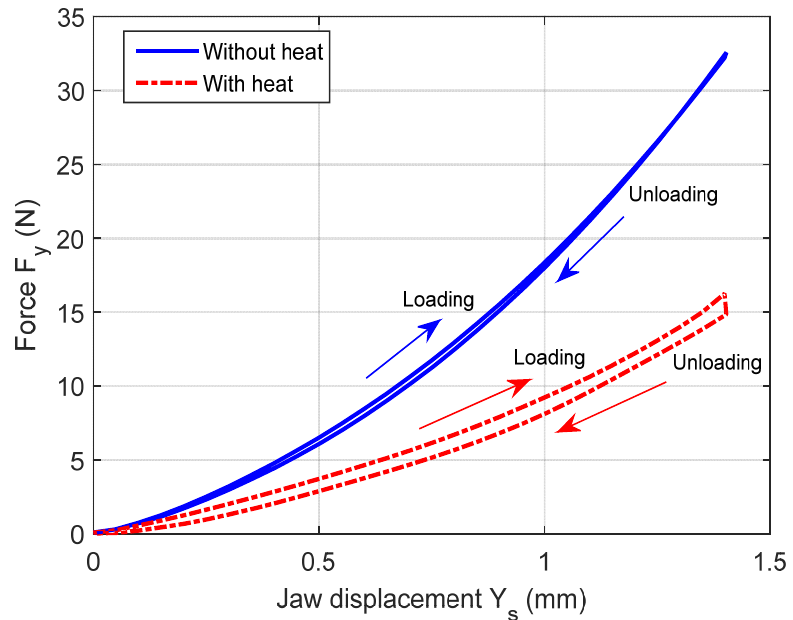
Figure 3. Testing results of the jaw mechanism with and without heat.